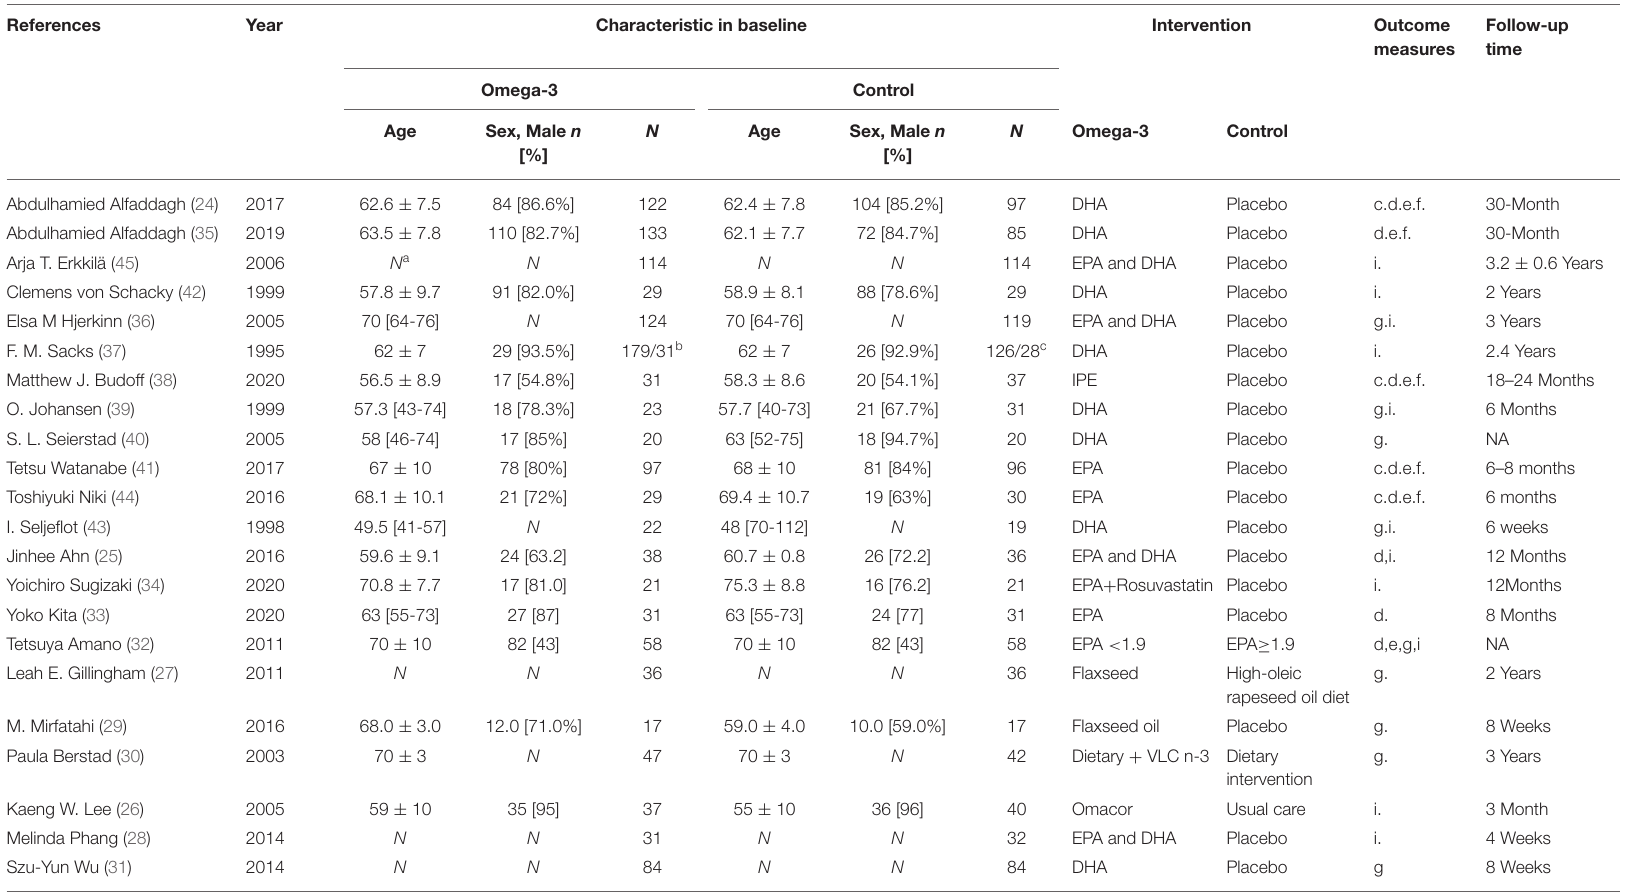
TABLE 1 | Characteristics of